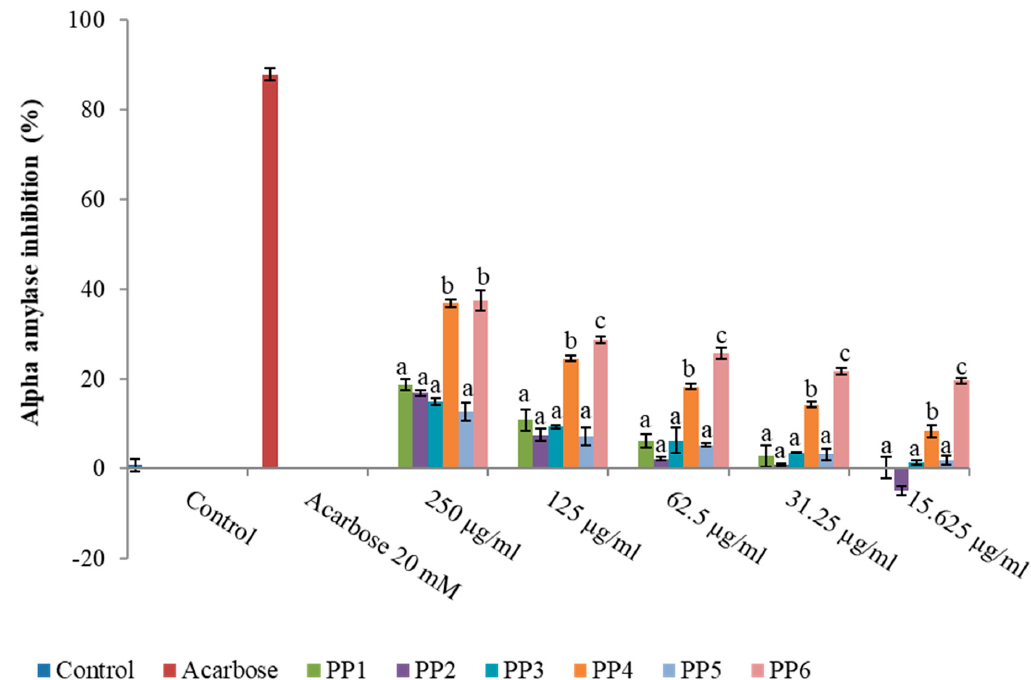
Figure 1. The inhibition of α -amylase by different fractions from the methanolic extract of Lauridia tetragona . The values are expressed as mean ± SD (n = 5). Bars with different letters at each concentration are significantly different ( p < 0.05).